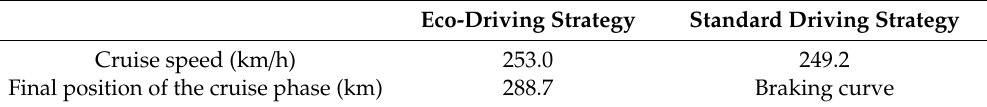
Table 2. Command vectors for the commercial time speed profiles obtained with the two considered driving strategies for Calatayud–Zaragoza